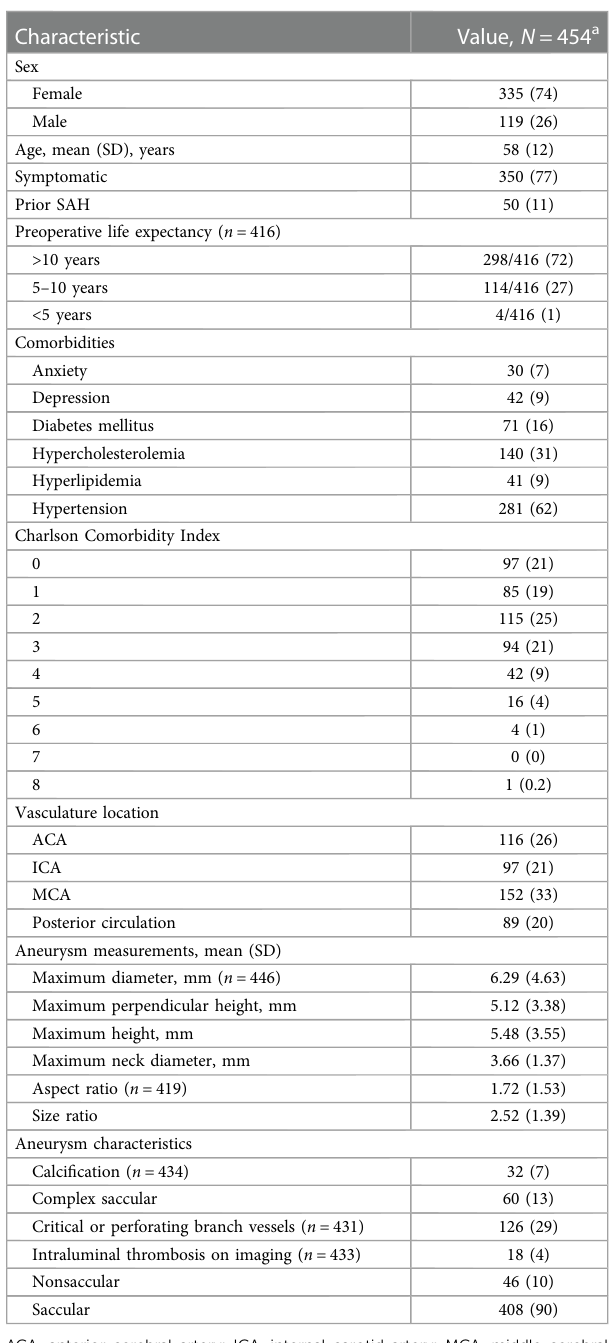
Table 5 reports symptoms by vascular territory. The proportion of patients with intracranial internal carotid artery aneurysms who were symptomatic (85 of 97 [88%]) was signi fi cantly greater than the proportion of patients with aneurysms in other locations who were symptomatic ( p = 0.03). patients harboring an intracranial ICA aneurysm, compared with patients with aneurysms in other vascular locations. The